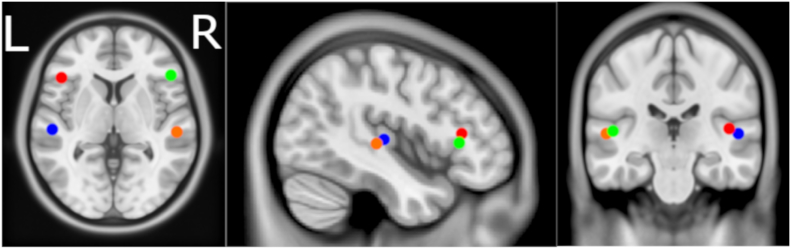
Location of dipoles modelled by dipole fitting. Centroids of the left (blue) and right (orange) superior temporal gyri and left (red) and right (green) inferior frontal pars triangularis were used to seed dipoles for dipole fitting. Axial MRI view is from above (L-Left, R-Right).